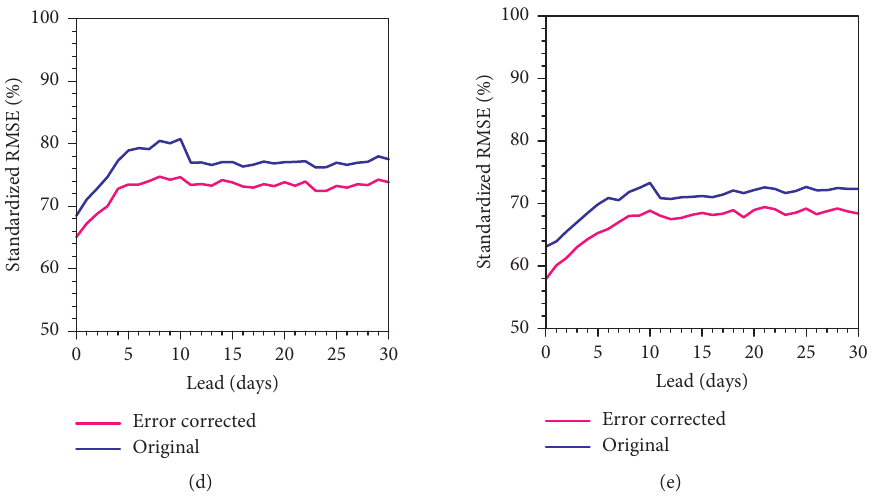
Figure 9: As in Figure 8, but for standardized RMSE. (a) Reg1, (b) Reg2, (c) Reg3, (d) Reg4, and (e)